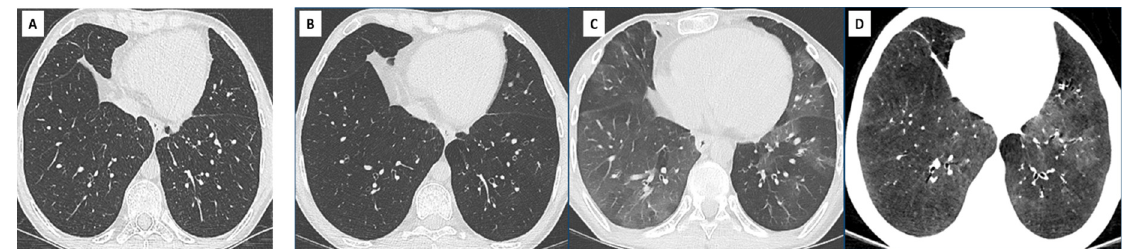
Figure 3. BOS in a 42-year-old patient. CT scans at CLAD diagnosis ( A ) and 2 years later ( B – D ); ( A ) August 2018: CLAD is diagnosed on spirometry with an obstructive profile. The CT scan does not show significant abnormality, confirming the BOS phenotype; ( B ) June 2020: inspiratory CT scan. Although the density of the lung parenchyma looks rather homogeneous, global hypoperfusion is obvious when comparing this CT to the baseline scan. The vessels are smaller and the overall density of the lung parenchyma is lower. There is no significant bronchial wall thickening nor large airway abnormality; ( C ) June 2020: expiratory scan unveils mosaicism and heterogeneous air trapping related to BOS; ( D ) June 2020: minimum intensity projection (mIP) technique applied on the inspiratory images (soft tissue kernel, parenchymal windowing) improves detection of mosaic perfusion with good correlation with expiratory images. This technique can be helpful in the absence of expiratory images or if the expiration has not been optimal.